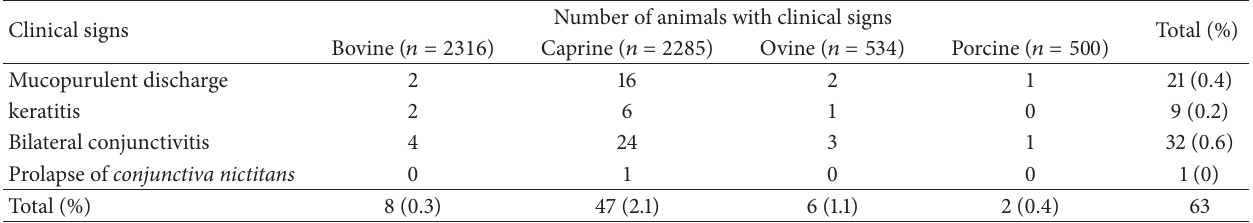
Table 1: Occurrence of clinical signs of ocular condition in food producing animal species.